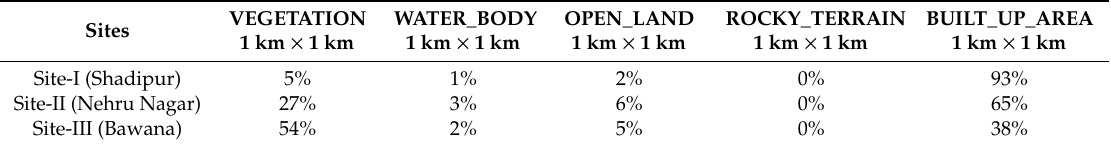
Table 2. Percentage of land use and land cover (LULC) classes in 1 km × 1 km grid of simulation sites.